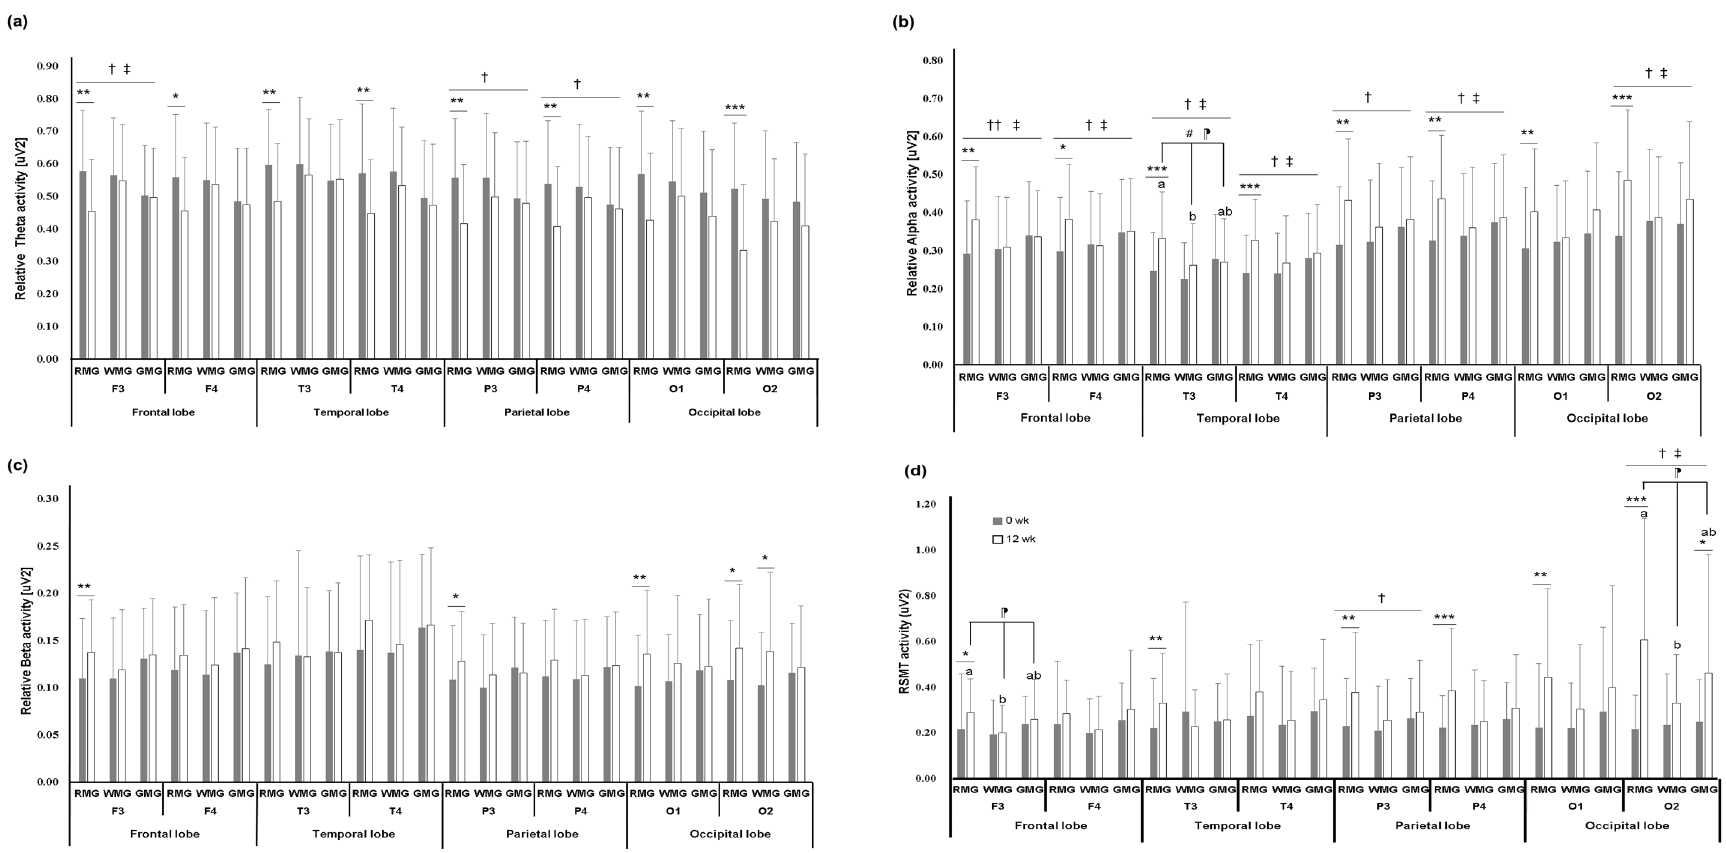
Figure 2. The EEG of ( a ) RT activity; ( b ) RA activity; ( c ) RB activity; ( d ) RSMT activity in 105 study subjects (intention-to-test approach). ‡ p < 0.05; time X group effect of two-way repeated measures ANOVA, † p < 0.05, †† p < 0.01; time X group effect of two-way repeated measures ANCOVA after adjusting for age, sex, and school, ¶ p < 0.05; analyzed by ANOVA and Hochberg’s post hoc test for comparing mean values of the RMG, WMG, and GMG at 12 weeks, # p < 0.05; analyzed by ANCOVA for comparing mean values of the RMG, WMG, and GMG after adjusting for age, sex, and school at 12 weeks by Bonferroni’s post hoc test for multiple comparison. Values with superscripts (a, b) differ significantly. * p < 0.05, ** p < 0.01, *** p < 0.001; analyzed by paired t -test between 0 weeks and 12 weeks, except for significant indications. F3: left frontal lobe; F4: right frontal lobe; GMG: general meal group; RA: relative alpha; RB: relative beta; RMG: rice meal group; RSMT: ratio of (SMR~Mid beta) to theta; RT: relative theta; SMR: sensory motor rhythm; T3: left temporal lobe; T4: right temporal lobe; O1: left occipital lobe; O2: right occipital lobe; P3: left parietal lobe; P4: right parietal lobe; WMG: wheat meal group.